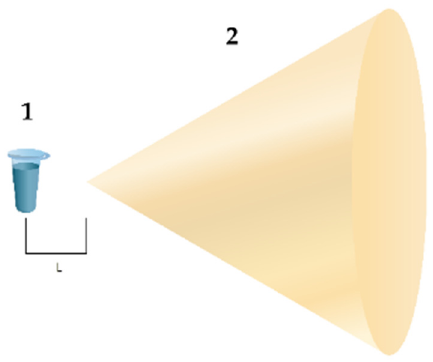
Figure 1. Experimental setup. Numbers indicate the main elements of the setup: ( 1 ) is the test tube with 0.1 µM HRP solution in 2 mM PBSD buffer, and ( 2 ) is the cellulose cone. The distance between the test tube and the cone apex is L = 2 cm.